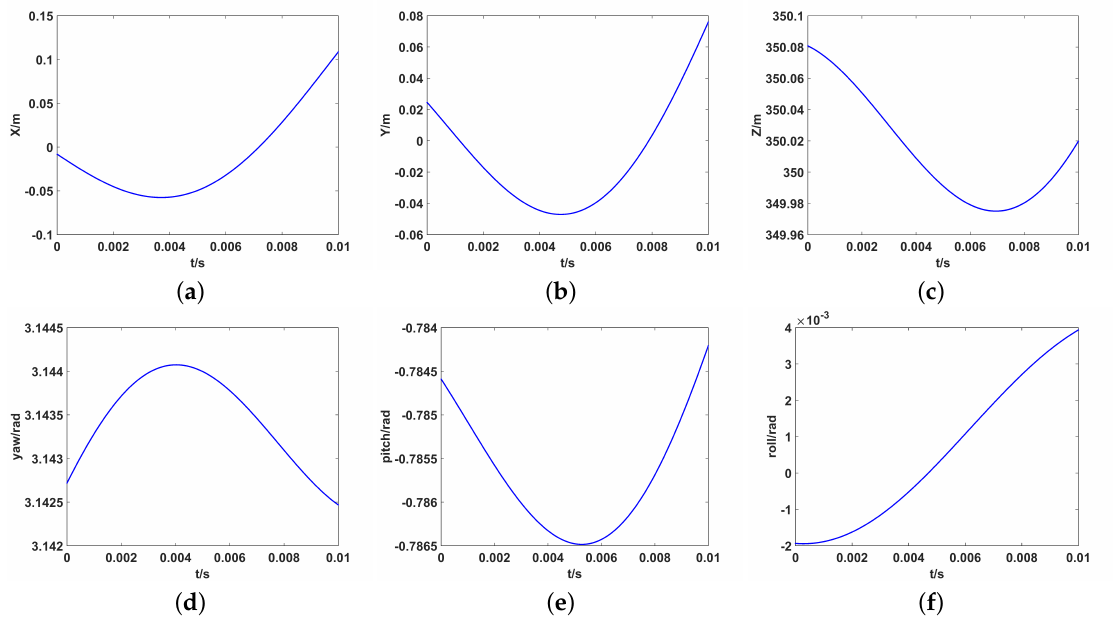
Figure 5. The motion trajectory of each component. ( a ) the translational component along the X t ; ( b ) the translational component along the Y t ; ( c ) the translational component along the Z t ; ( d ) the rotation of yaw; ( e ) the rotation of pitch; ( f ) the rotation of